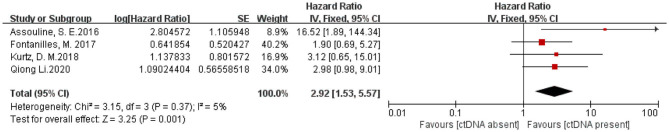
Forest plot of a Fixed-effect meta-analysis of the prognostic role of ctDNA on overall survival.